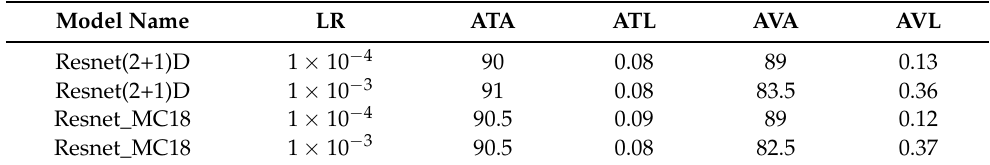
Table 10. Video classifier results by